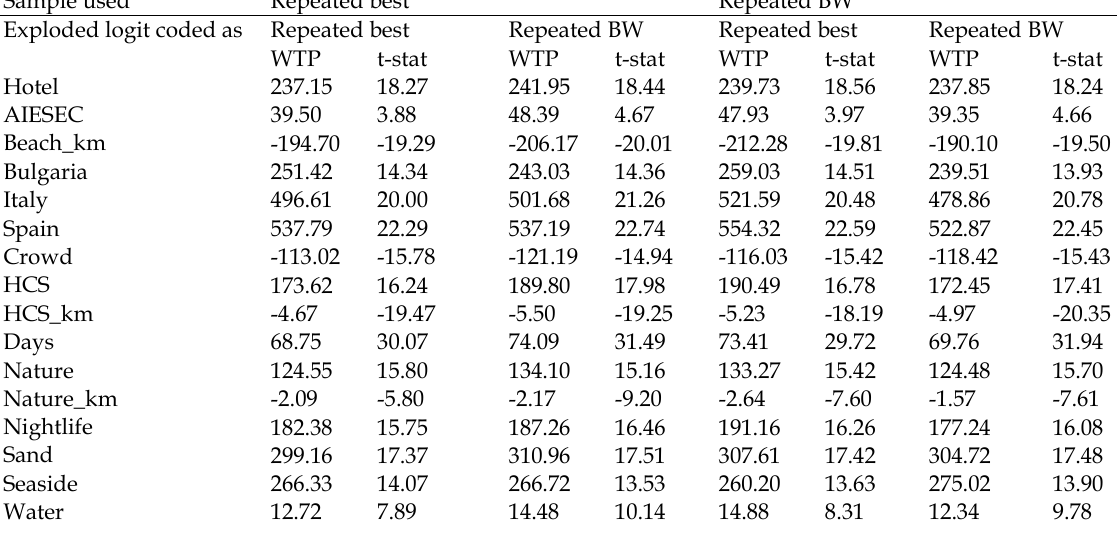
Table 7. WTP estimates depending on the assumed exploded logit model